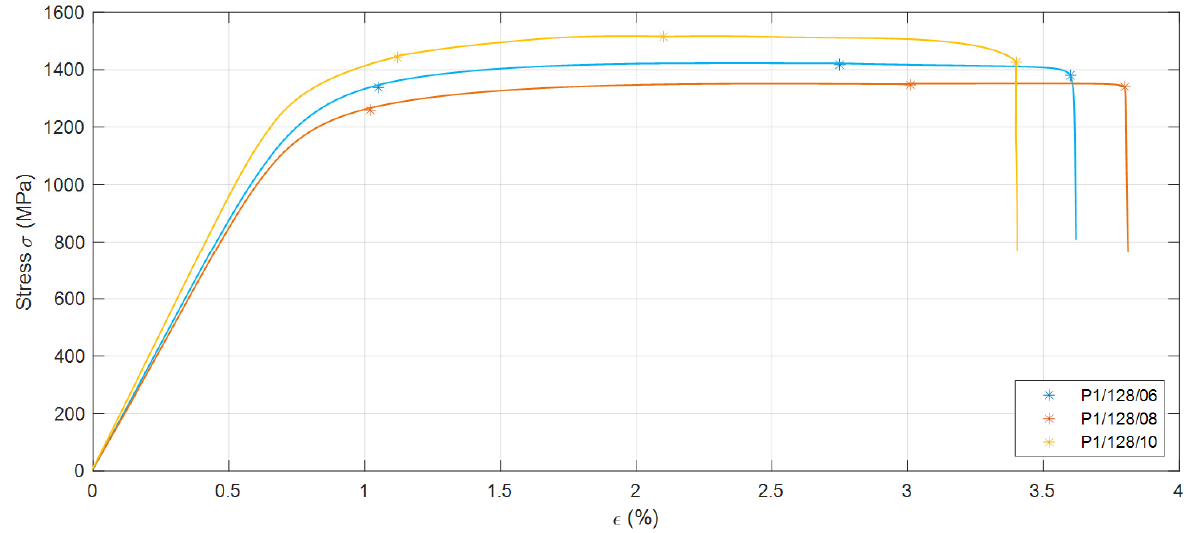
Figure 1. Tensile stress–strain curves.